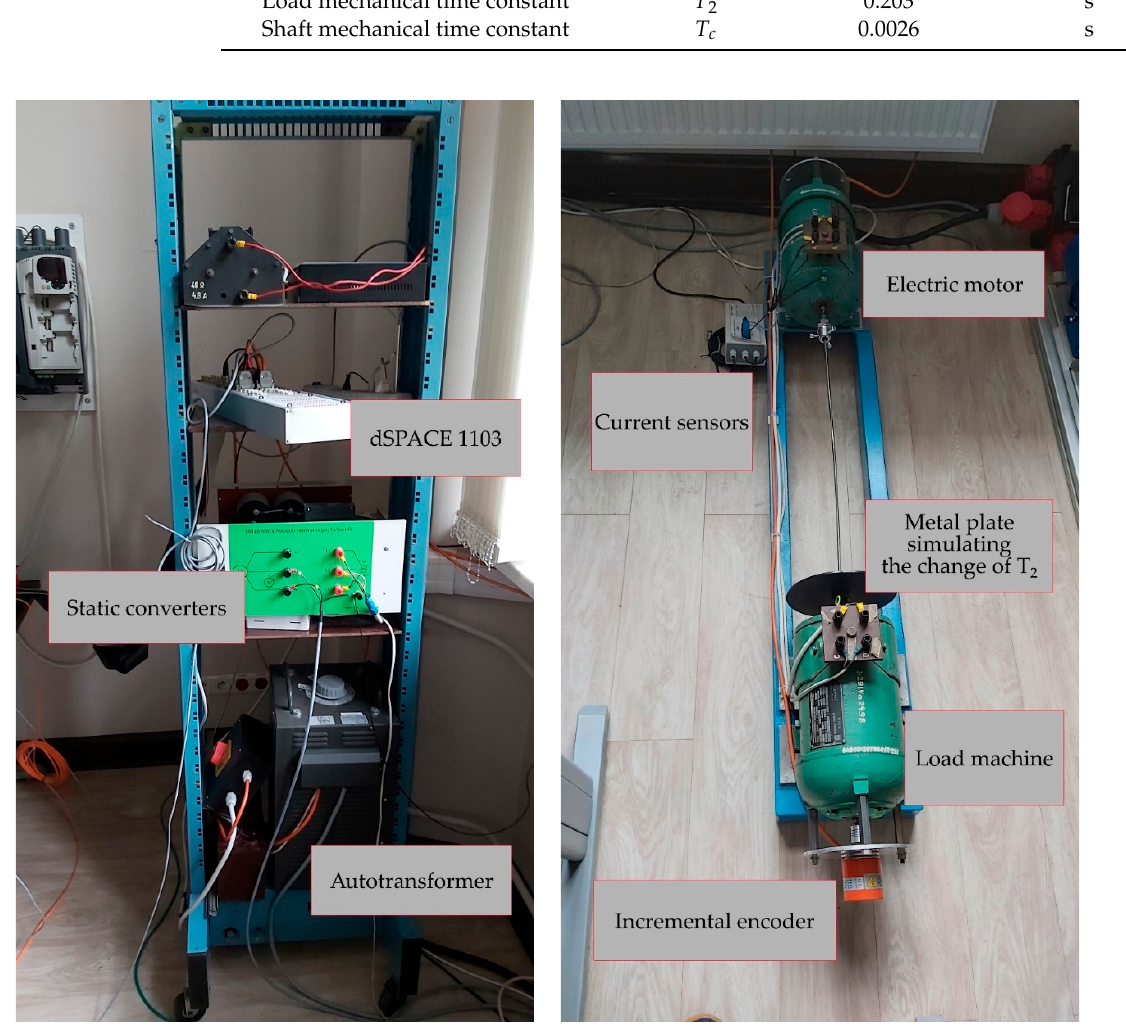
Figure 10. The experimental set-up: left —power electronic devices, right —electrical